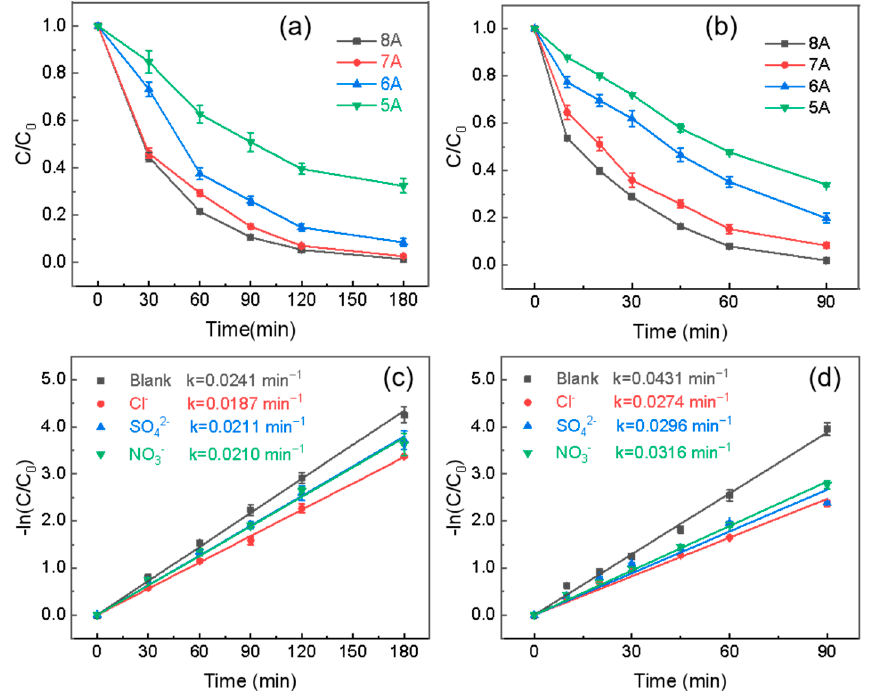
Figure 4. Effect of inorganic anions on the photodegradation of ( a ) SMX and ( b ) ENR, and kinetic